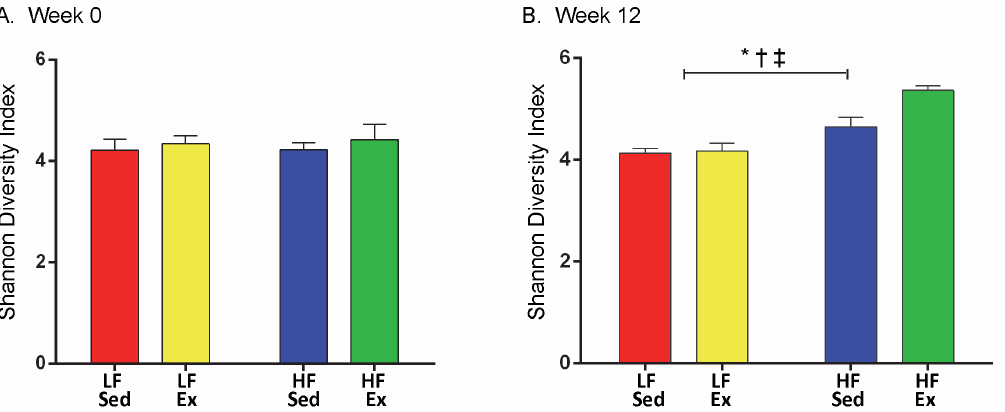
Figure 3. Beta Diversity is Elevated by HF Diet and Exercise. Significant differences indicated as follows: ‘‘*’’ p , 0.05 for diet effect, ‘‘ { ’’ p , 0.05 activity effect and ‘‘ ` ’’ p , 0.05 diet and activity interaction. n=6 mice/group.